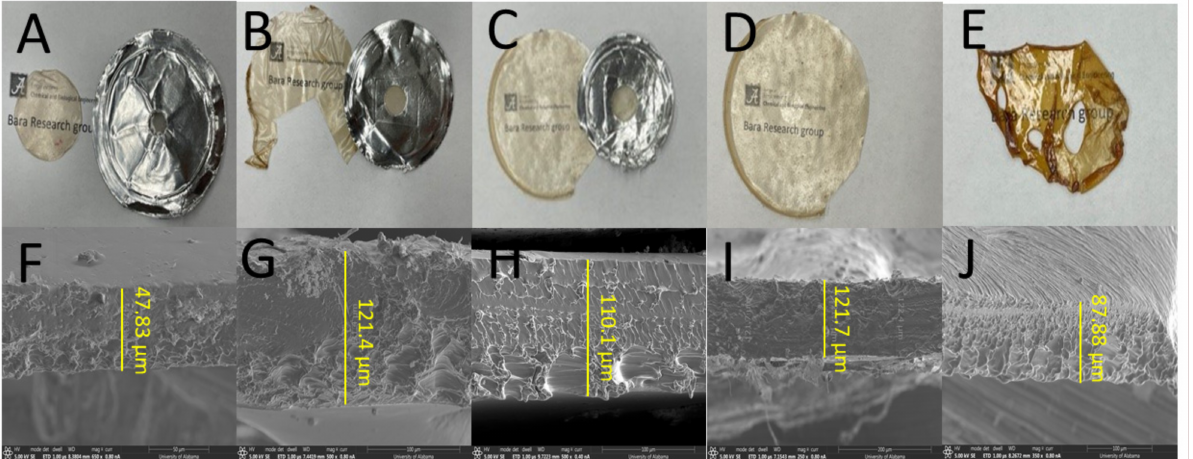
Figure 4. ( A – E ) Photographs of the p ([NBM-mIm][Tf 2 N]) and BCPs membranes, and ( F – J ) their corresponding SEM images at a magnification between 250X and 650X. Membrane’s thickness are in the range of 47–125 µ m. ( A , F ) p ([NBM-mIm][Tf 2 N]), ( B , G ) BCP1-C 4 , ( C , H ) BCP2-C 4 , ( D , I ) BCP1-C 6 and ( E , J ) BCP2-C 6 .